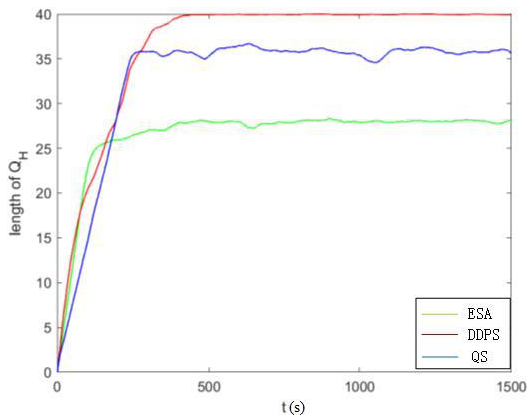
Figure 9. Comparison of average time delays under different algorithms.